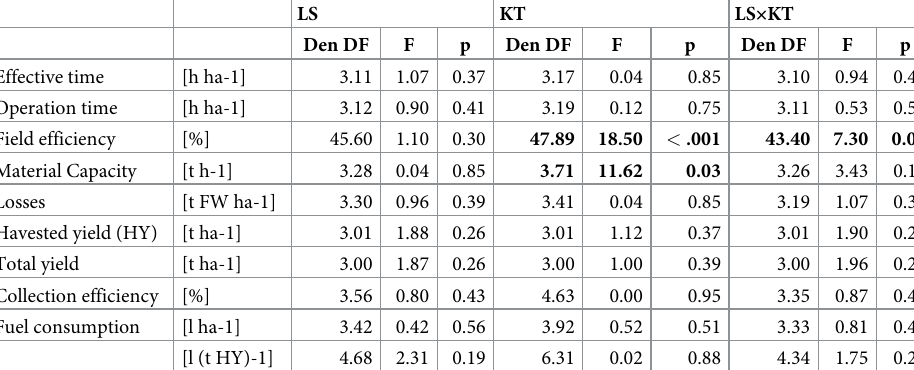
Table 5. Results of the general linear mixed analysis of the machine performance in term of Loading system (LS), knife type (KT) and their interaction. Factors and interaction at p < 0.05 are shown in bold. Replicates are shown in Table 2, the covariates effect is shown in the S3 Table.